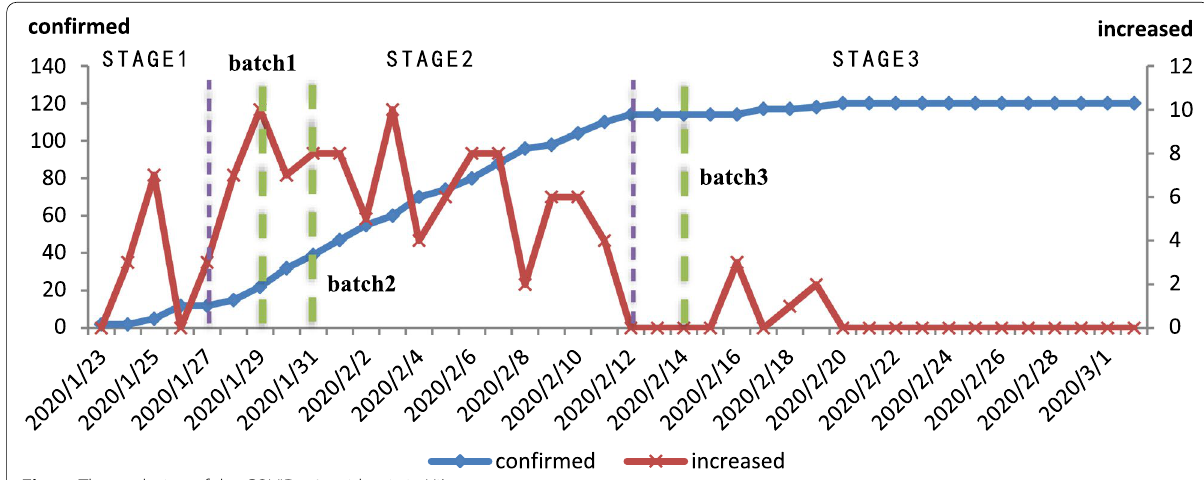
Fig. 1 The evolution of the COVID-19 epidemic in